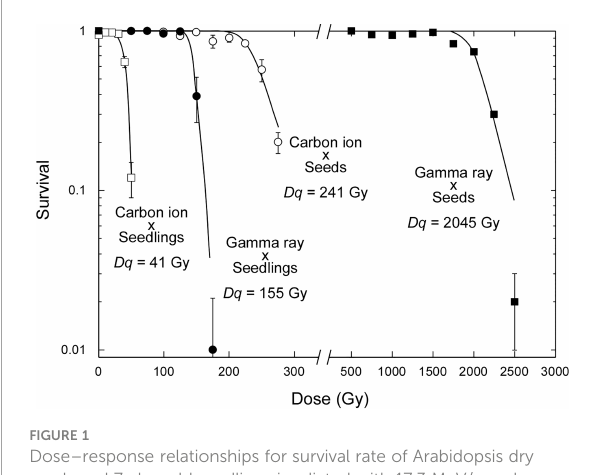
FIGURE 1 Dose – response relationships for survival rate of Arabidopsis dry seeds and 7-day-old seedlings irradiated with 17.3 MeV/u carbon ions or gamma rays. Data points are the mean ± standard error